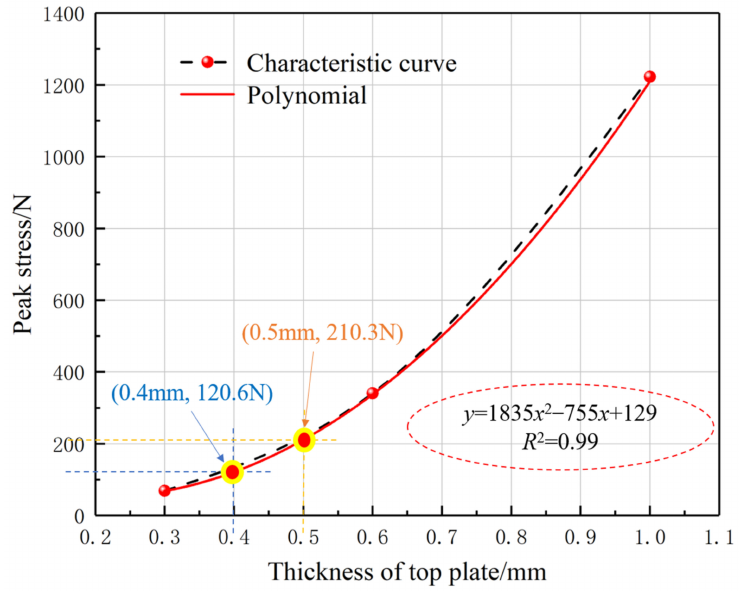
Figure 15. Peak stress with fitting curve for top tray